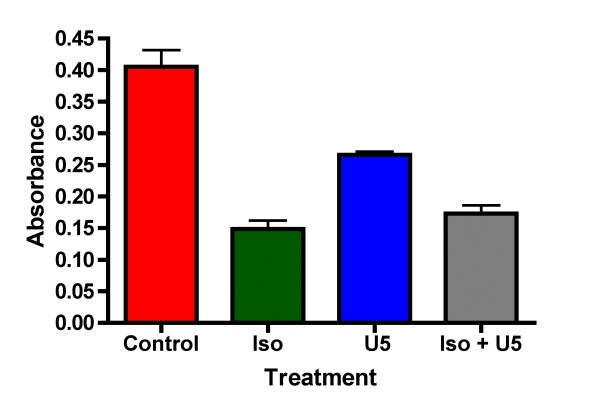
Inhibition of proliferation in H69 cells by the β-adrenergic agonist isoproterenol and the GIRK channel inhibitor U50488H. H69 cells were grown in the presence of isoproterenol or U50488H or a combination of Iso and U5 for 48 hours. Proliferation was determined by a BrdU assay. Both 10 μM Iso (p < 0.001) and 2 μM U5 (p < 0.001) inhibited proliferation with Iso having the greater effect. The effect of the GIRK inhibitor U5 on proliferation was potentiated by Iso (p < 0.001). N = 5.